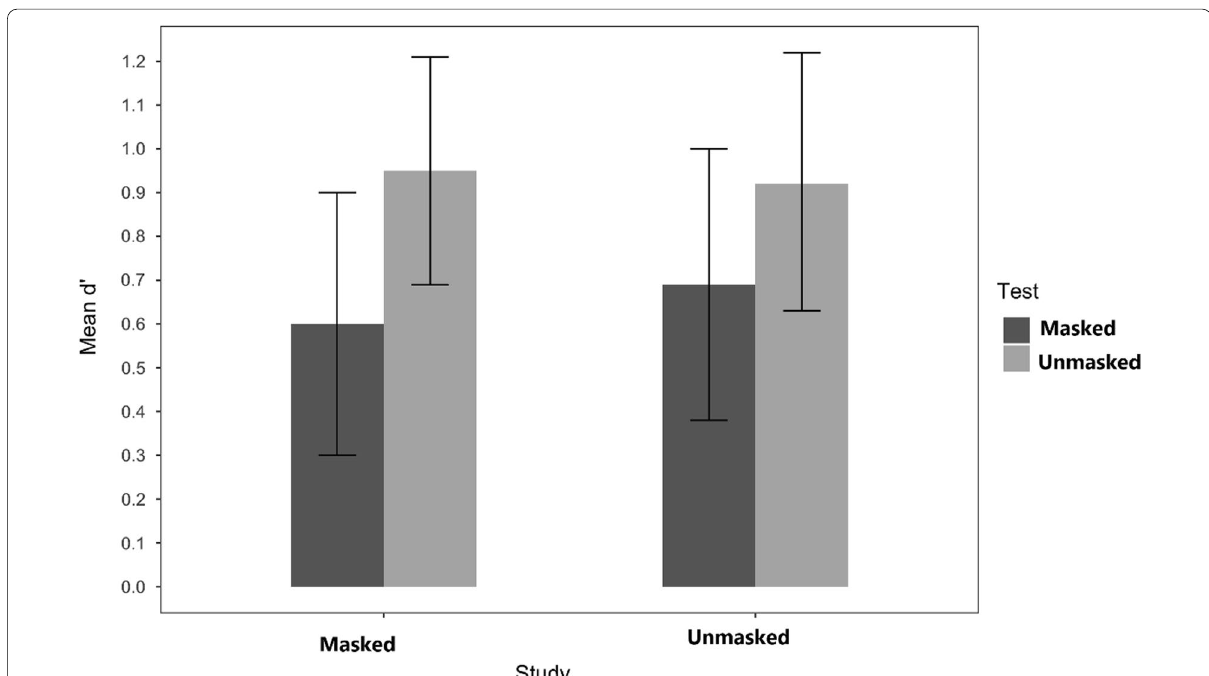
Fig. 5 Experiment 2: Sensitivity d’. Note. Mean response sensitivity for faces studied with and without a mask and subsequently tested either with or without a mask (Experiment